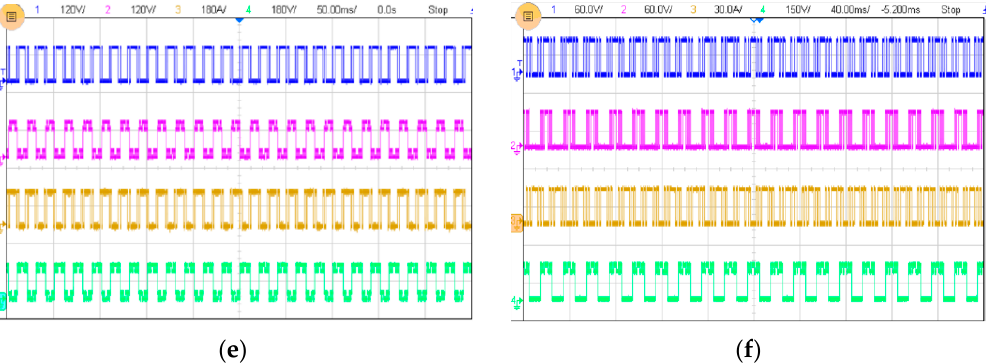
Figure 15. Experimental blocking voltage across various switches (S) in 13-level inverter ( a ) S ’ 1 , S 3 , and S 4 ; ( b ) S 1 , S ’ 4 ; ( c ) S 1 , S 3 , and S 4 ; ( d ) S ’ 1 ; ( e ) S 2 ; and ( f ) S ’ 2 .